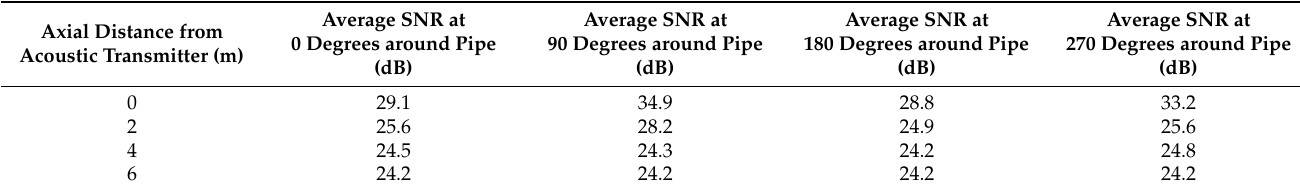
Table 2. Average SNR (dB) at each circumferential position around and axial distance along the exposed (empty) MDPE